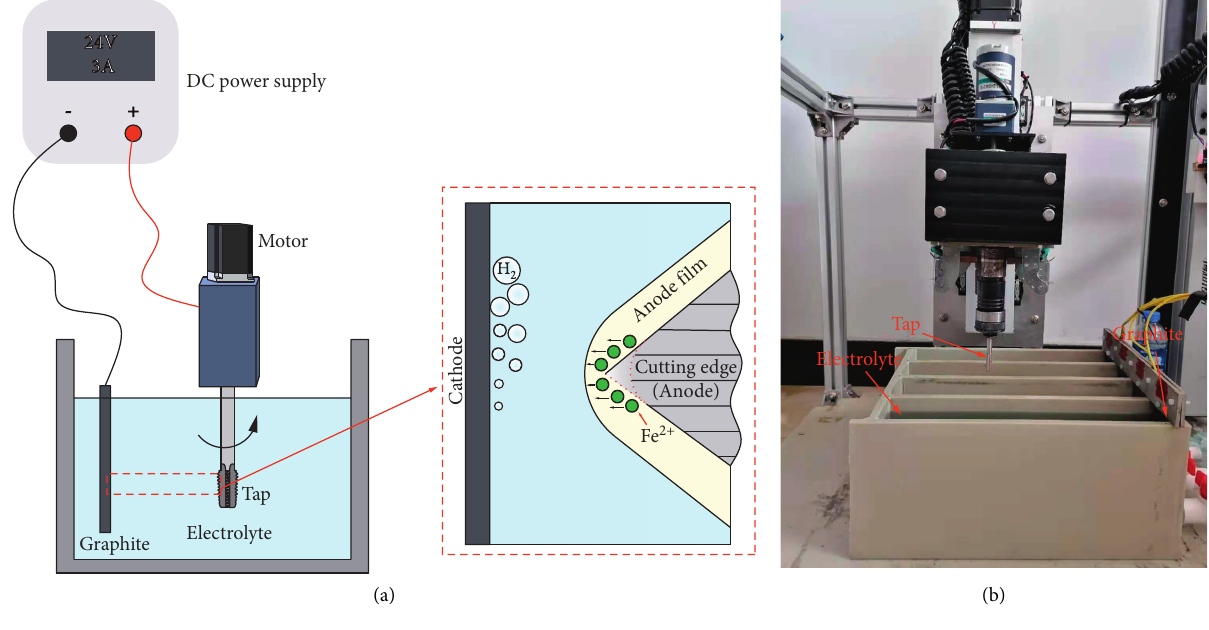
Figure 4: Electrolysis principle and equipment. Table 3: Preparation parameters of hone radius.